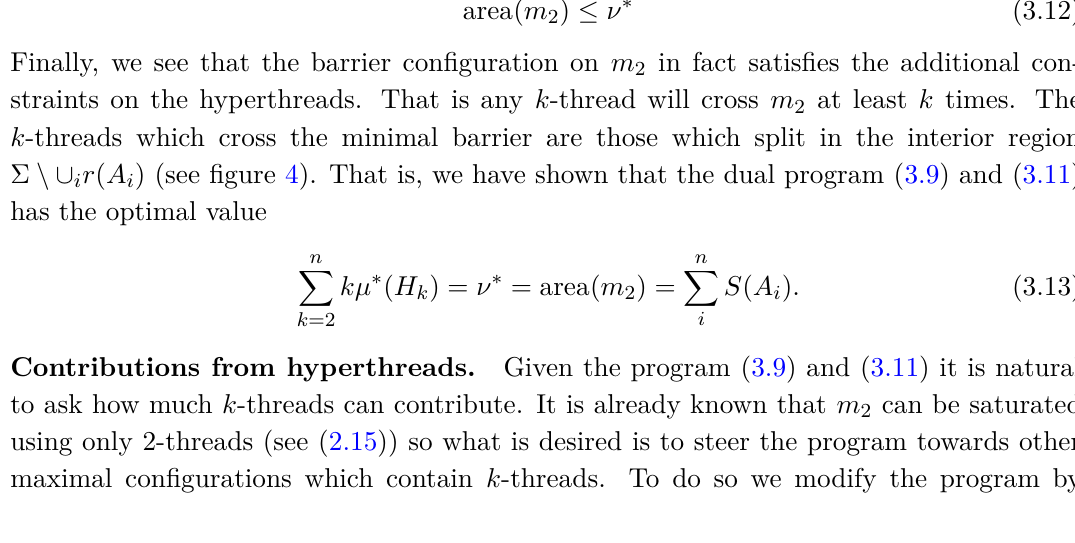
Figure 4 . An example for three regions in AdS 3 . All 2-threads will cross a barrier of 2. There are two classes of 3-threads the first splits in one of the homology regions r ( A barrier of 4 and will not contribute to the optimal configuration. The rest split in the interior region Σ \ ∪ ( A ) and cross a total barrier of 3; these can i r i